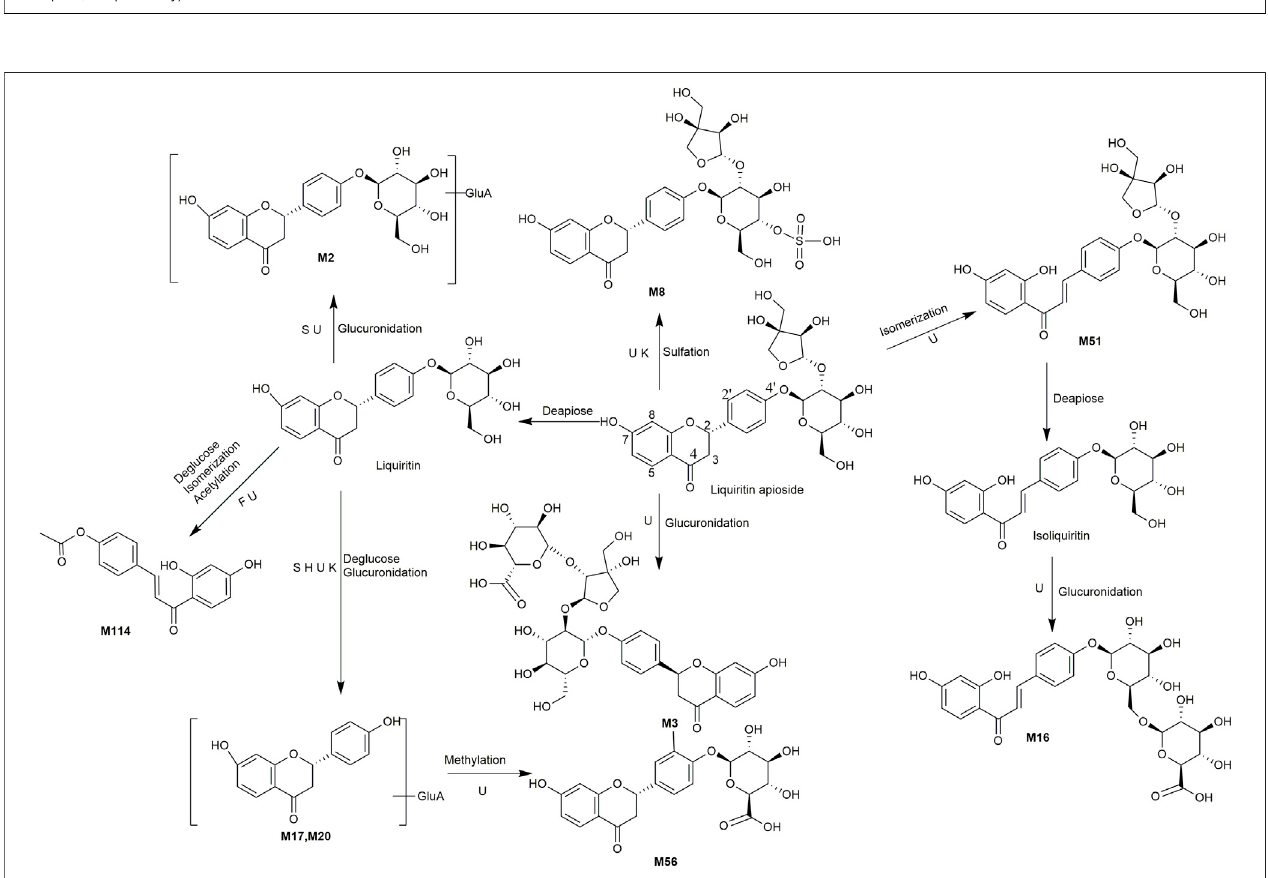
FIGURE5| Theproposedmetabolicpathwaysofliquiritinapioside-relatedmetabolitesinratsbiosamples.(S,H,FandUrepresentedserum,heart,fecesandurine samples, respectively).